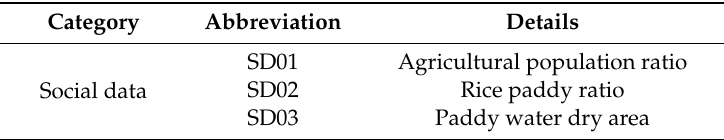
Table 3. Social data details and abbreviations.